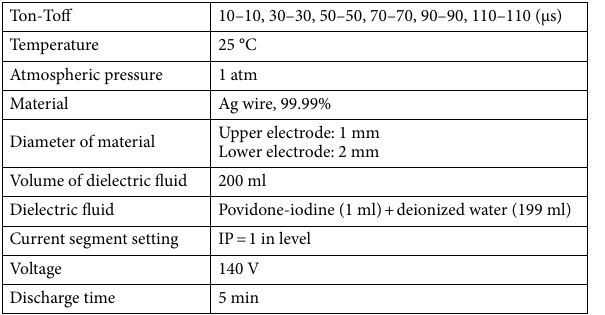
Table 1. EDM parameters for preparing